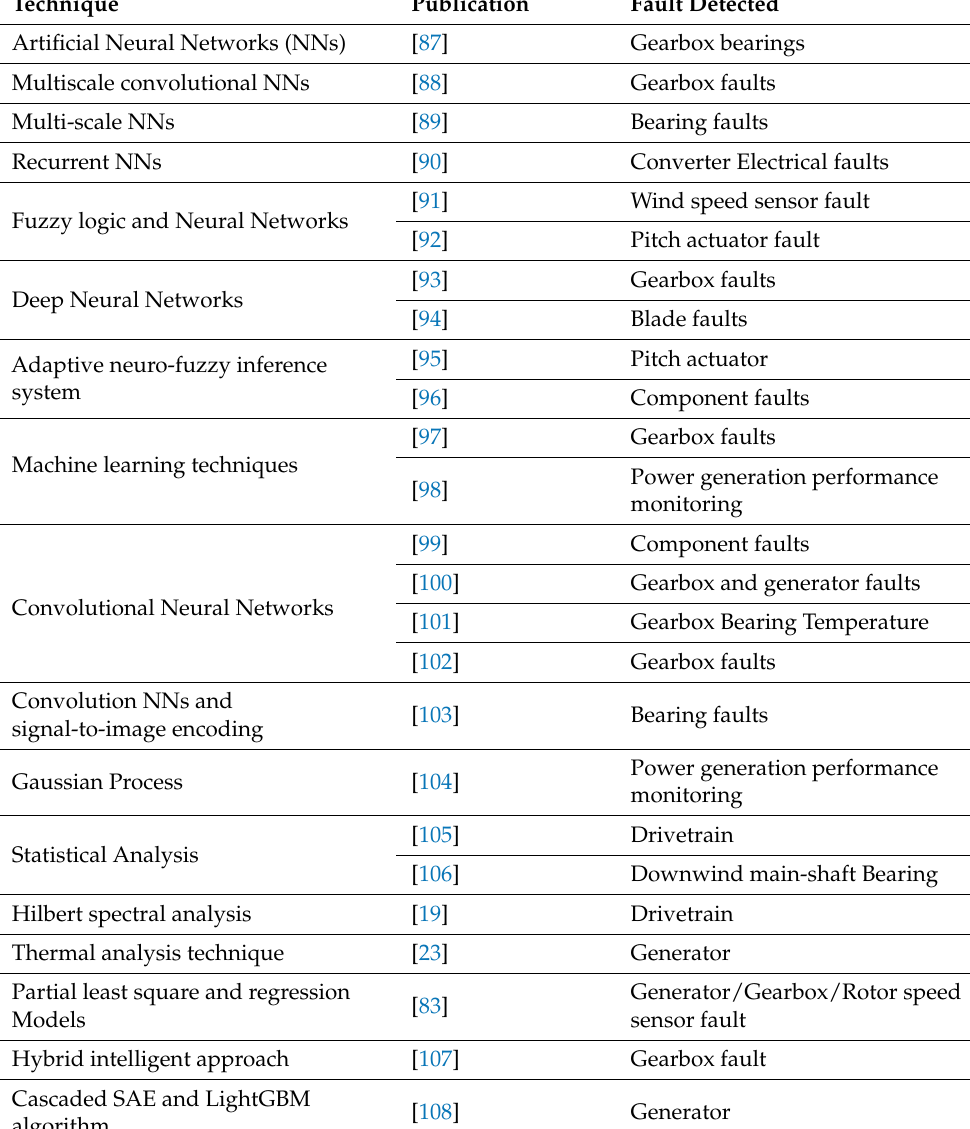
Table 3. List of some of the most relevant data-driven FDD